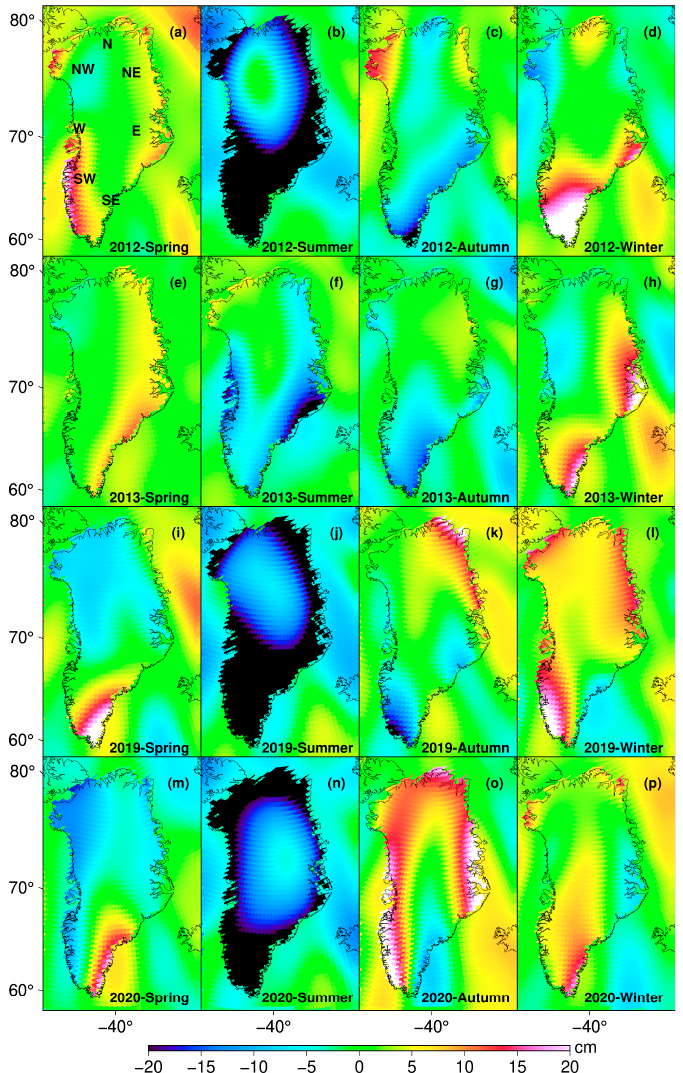
Figure 4. Spatial distribution of seasonal mass variations over the GrIS in 2012 ( a – d ), 2013 ( e – h ), 2019 ( i – l ), and 2020 ( m – p ). Note, the following abbreviations are used: South West (SW), West (W), North West (NW), North (N), North East (NE), East (E), and South East (SE).